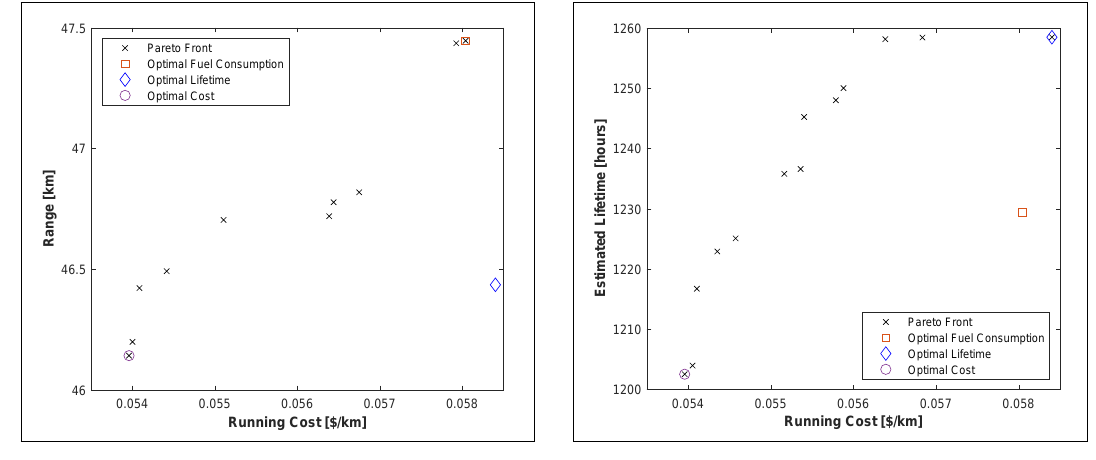
Figure 12. Pareto curve for overall operating